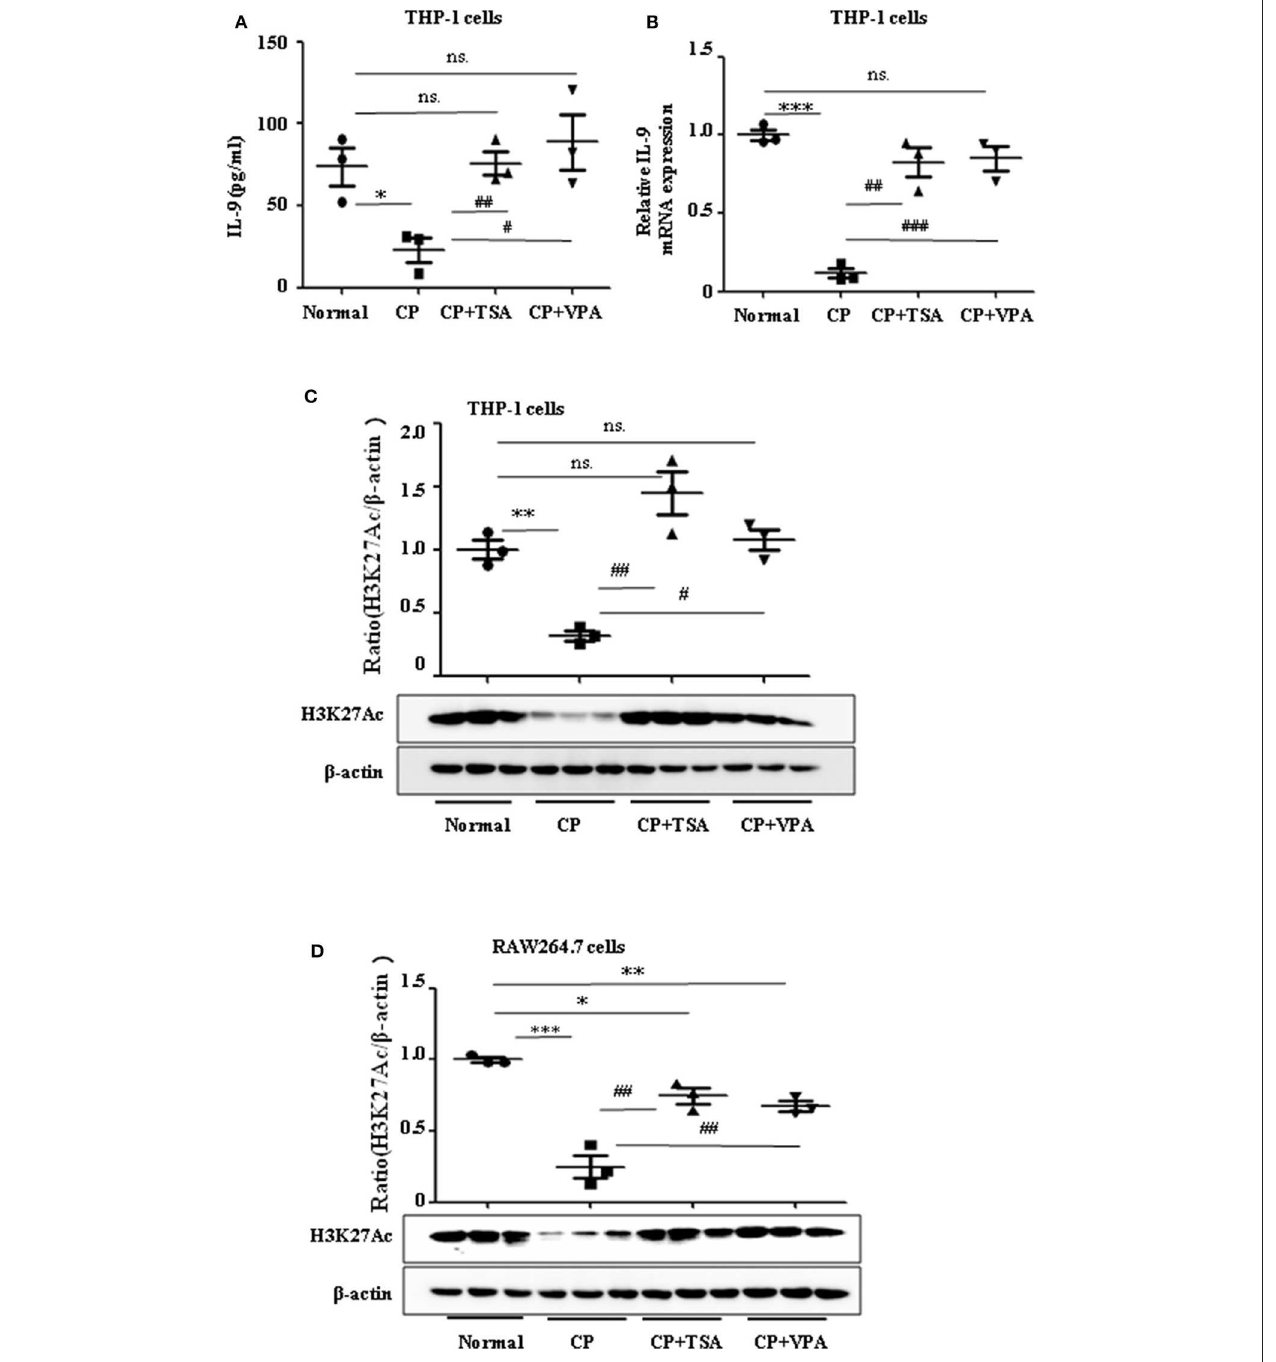
FIGURE 5 | Trichostatin A (TSA) or valproate (VPA) upregulated interleukin-9 (IL-9) with cisplatin (CP) administration in vitro . Data are represented as mean ± SD of three independent experiments. (A) The level of IL-9 in CP-induced THP-1 cells with treatment of TSA (0.1 µ mol/L) or VPA (1 mmol/L) respectively by ELISA. * P < 0.05 vs. the Normal group; ## P < 0.01, # P < 0.05 vs. the CP-treated group. (B) The mRNA level of IL-9 in CP-induced THP-1 cells with treatment of TSA (0.1 µ mol/L) or VPA (1 mmol/L), respectively. Dot plots show the corresponding quantification of mRNA level and fold change. *** P < 0.001 vs. the Normal group; ### P < 0.001, ## P < 0.01 vs. the CP-treated group. (C) Western blot was performed on CP-induced THP-1 cells with treatment of TSA (0.1 µ mol/L) or VPA (1 mmol/L), respectively, to determine H3K27Ac expressions. Each lane represents one sample from an individual mouse. Dot plots show the corresponding quantification of band intensity and fold change. ** P < 0.01 vs. the Normal group; ## P < 0.01, # P < 0.05 vs. the CP-treated group. (D) Western blot was performed on CP-induced RAW264.7 cells with treatment of TSA (0.1 µ mol/L) or VPA (1 mmol/L), respectively, to determine H3K27Ac expressions. Each lane represents one sample from an individual mouse. Dot plots show the corresponding quantification of band intensity and fold change. *** P < 0.001, ** P < 0.01, * P < 0.05 vs. the Normal group; ## P < 0.01 vs. the CP-treated group.